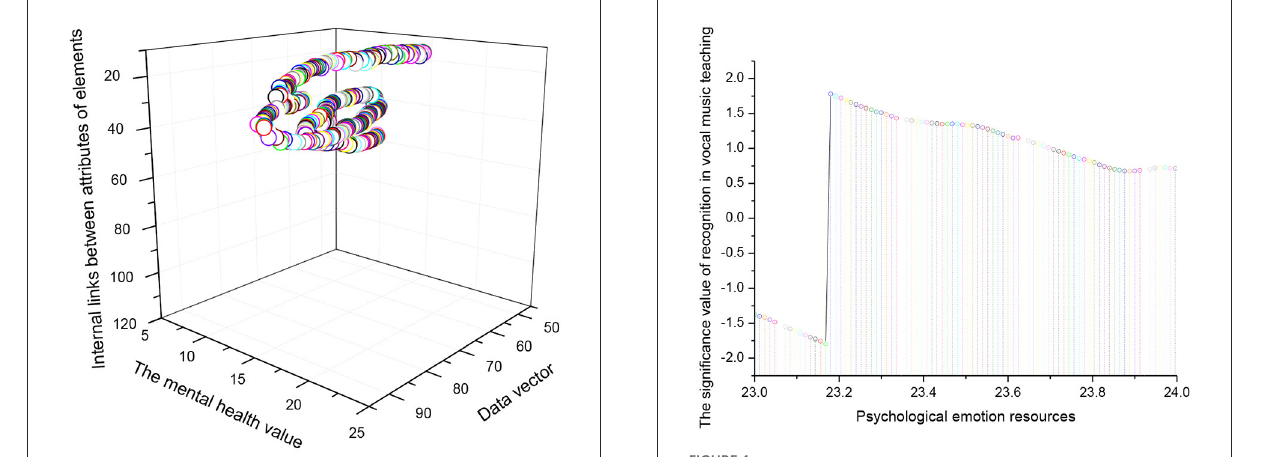
FIGURE3 Internal links between attributes of mental health elements.